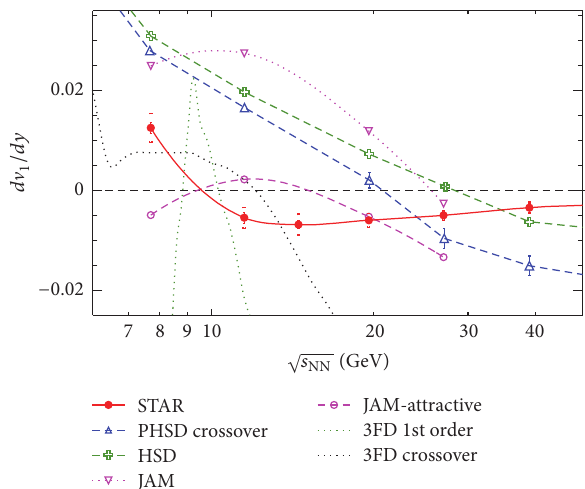
Figure 13: Beam energy dependence of directed flow slope for protons in 10–40% centrality Au+Au from the STAR experiment, compared with recent available model calculations [19, 20, 94]. All the experimental data are from [47] except for one energy point, √𝑠 = 14.5 GeV [90], which should be considered a preliminary NN measurement. The Frankfurt hybrid model [95] and a pure hydro calculation with particle freeze-out at constant energy density [95] both lie above the data and are off-scale at all BES energies.